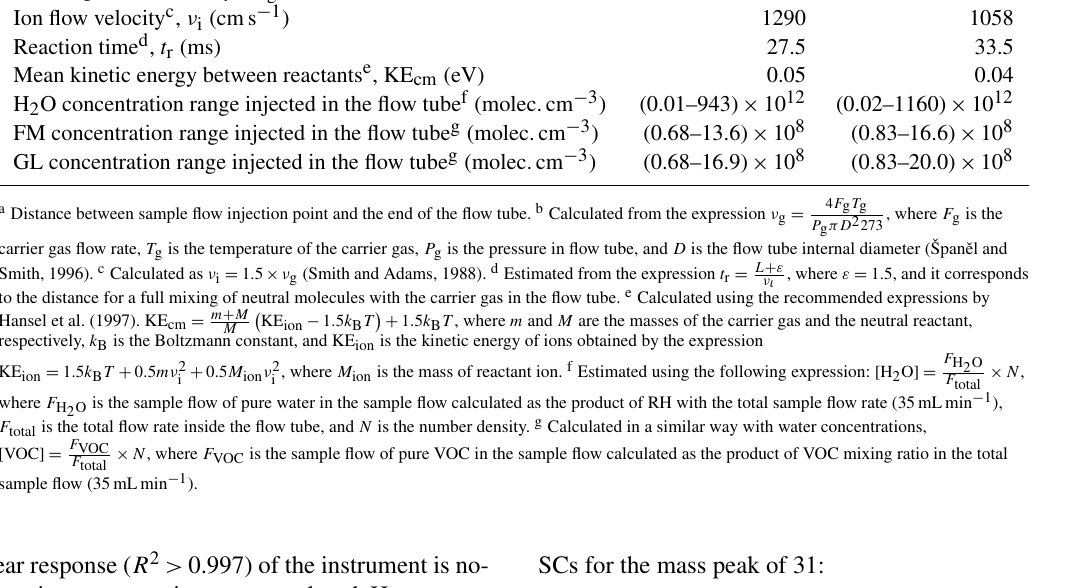
Molecular density in the flow tube, N (molec.cm − 3 )